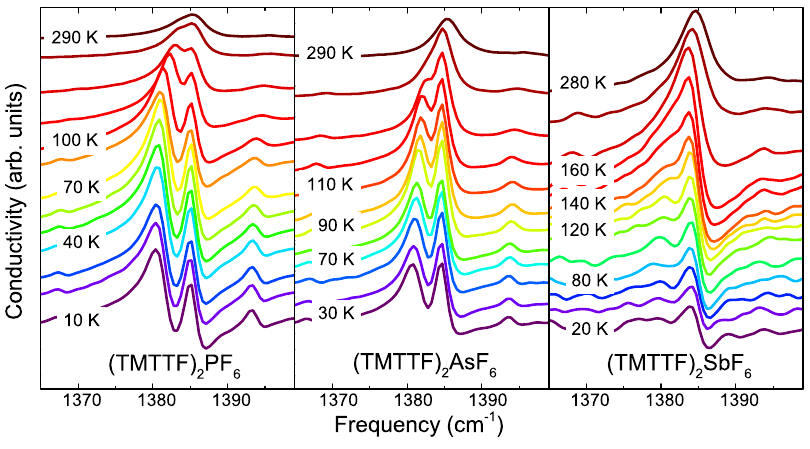
mode measured along the 3 SbF single crystals. Two 2 6